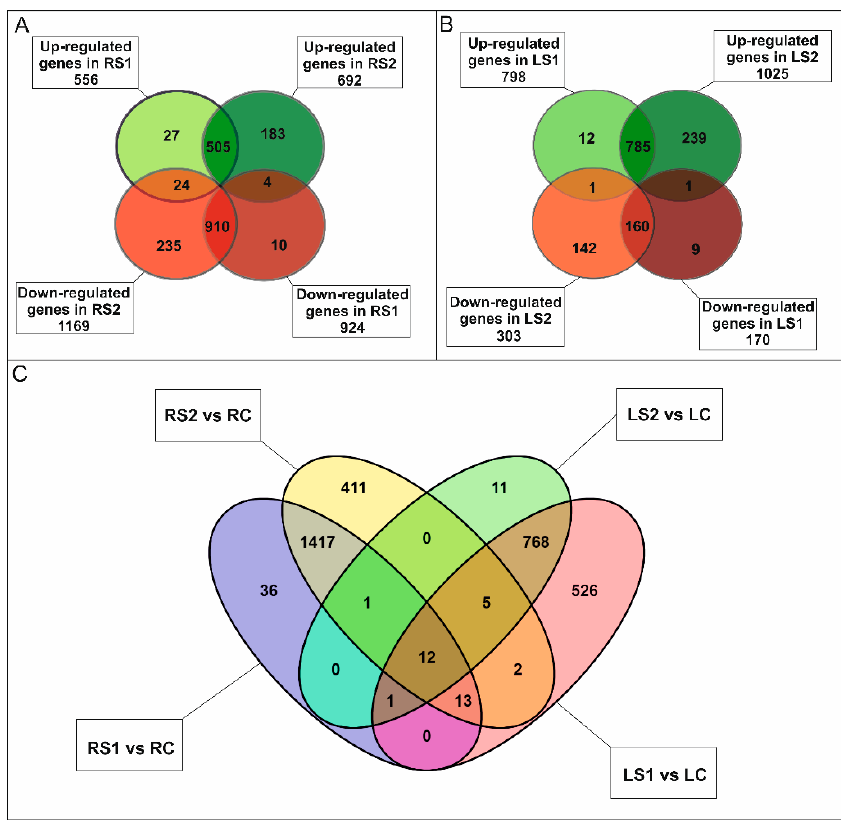
Figure 2. Transcriptomic analysis of fine, absorptive roots and leaves during senescence. ( A ) Venn diagrams showing the expression pattern of 1898 statistically significant differentially expressed genes (DEGs) in fine roots at two time points during senescence and the overlap in expression among them. ( B ) Venn diagrams showing the expression pattern of 1348 statistically significant genes in leaves at two time points during senescence and the overlap in expression among them. ( C ) Venn diagram showing the expression pattern of DEGs in roots and leaves at two time points during senescence and the common genes for both organs.